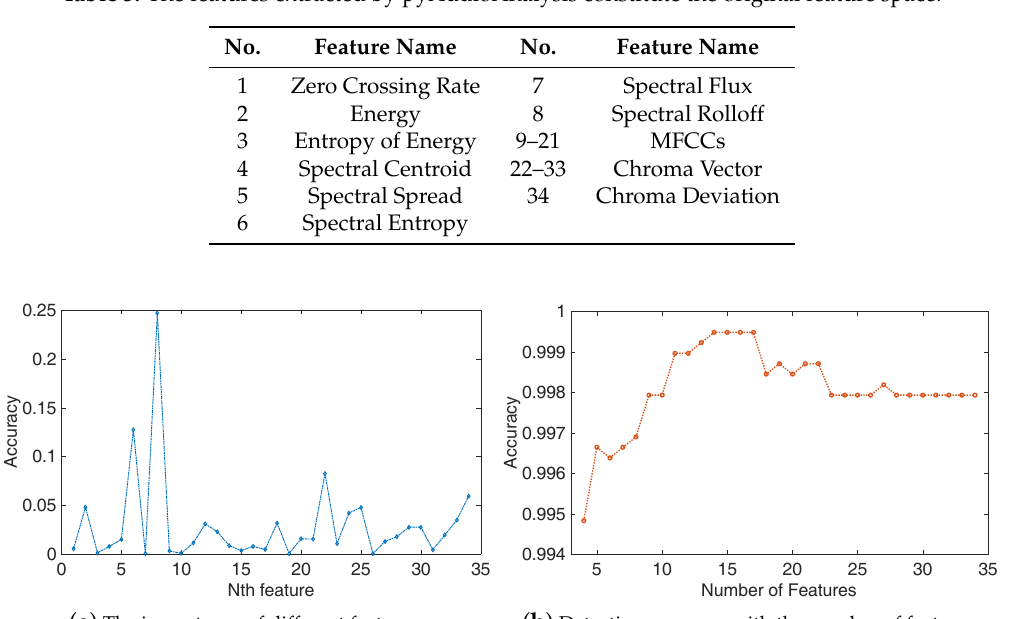
Figure 10. The impact of features on the performance of detection. ( a ) The importance of different features, we use the RandomForest classifier to evaluate the importance of different features; ( b ) Detection accuracy with the top N